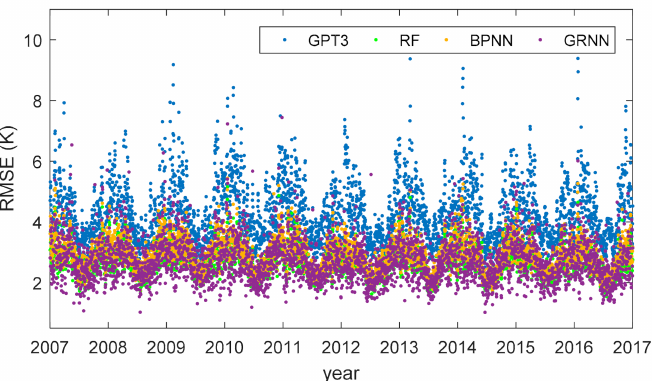
Figure 10. Root mean square errors of different models at different days.